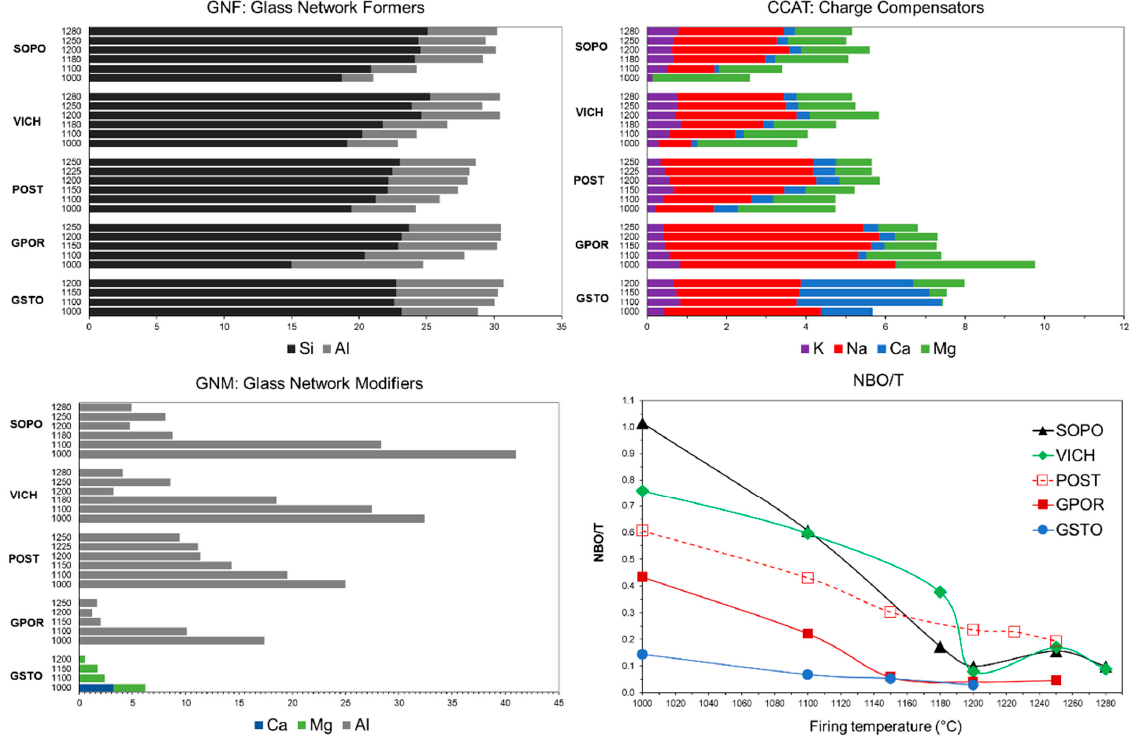
Figure 10. Pseudo-structural parameters of non-crystalline matrix vs. firing temperature.